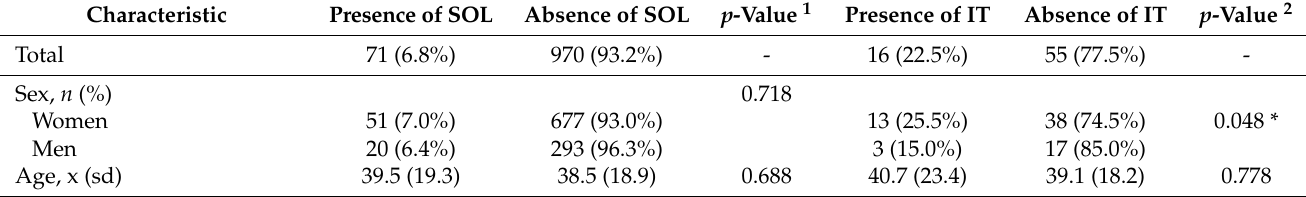
Table 2. Main characteristics of the subgroup of patients who presented a structural finding poten- tially explaining headache ( n = 224), stratified by the presence of space-occupying lesions (SOL) and, from this subgroup, stratified by the presence of intracranial tumors